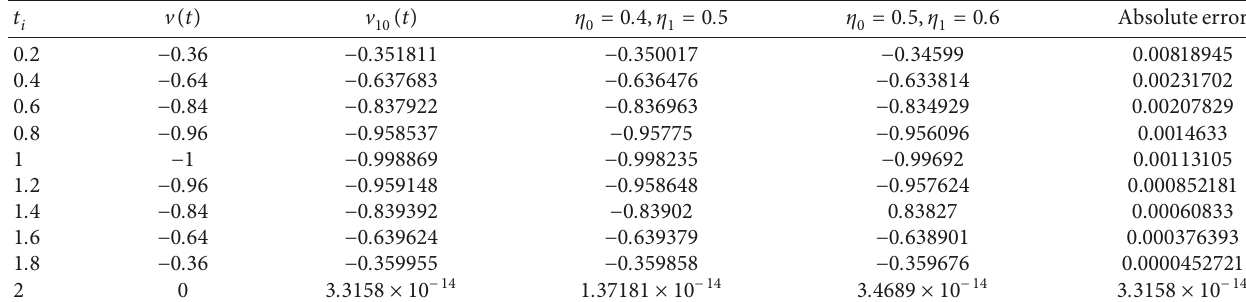
Table 3: Numerical solution for Example 3 with n �